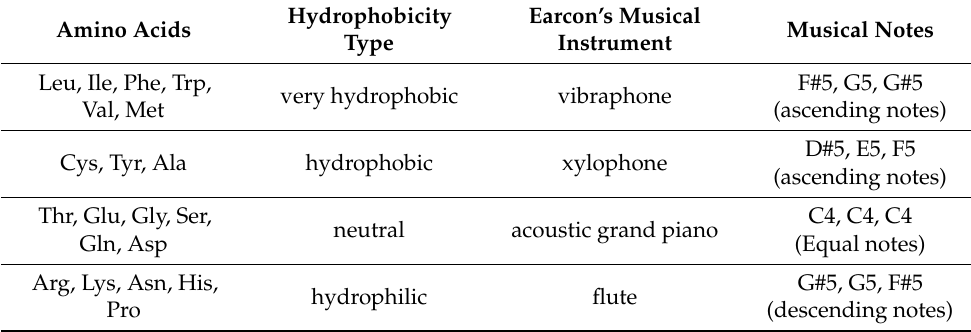
Table 5. Mappings of amino acids and earcons played in P™ (TM). Amino